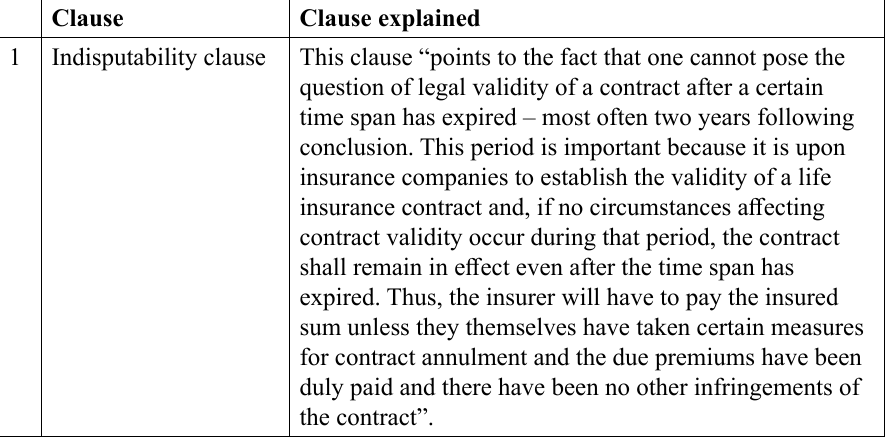
Table 2. Clauses protecting both contracting parties in life